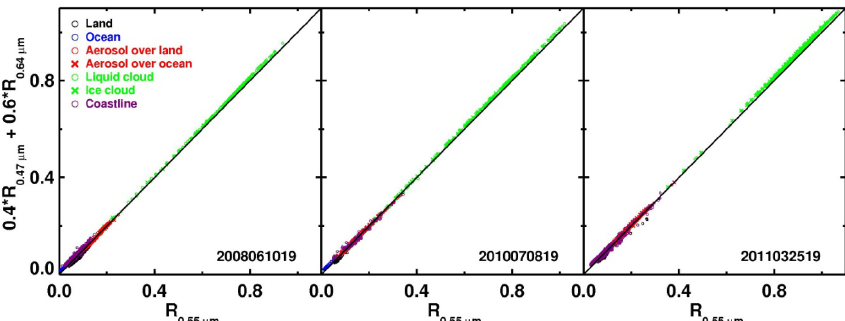
Figure 6c Fig. 6c. Same as in Fig. 7a, but for 25 March 2011.